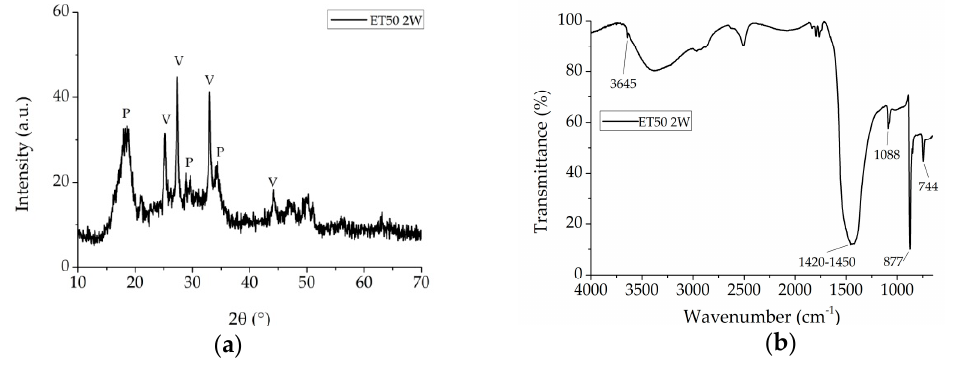
Figure 3. Ca(OEt) 2 at 50% RH after two weeks (ET50 2W): ( a ) XRD pattern; ( b ) μ FT-IR spectrum. XRD peak assignments: P, portlandite; V, vaterite.